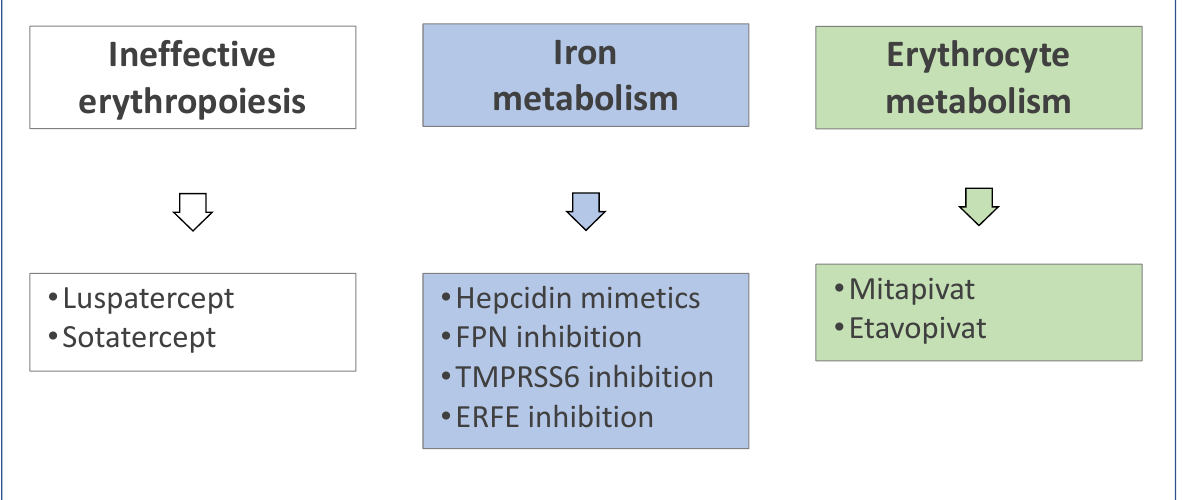
Figure 2. Potential new treatments emerging from advances in the pathophysiology of thalassemia (ERFE = erythroferrone; FPN = ferroportin; TMPRSS6 = transmembrane serine protease 6).